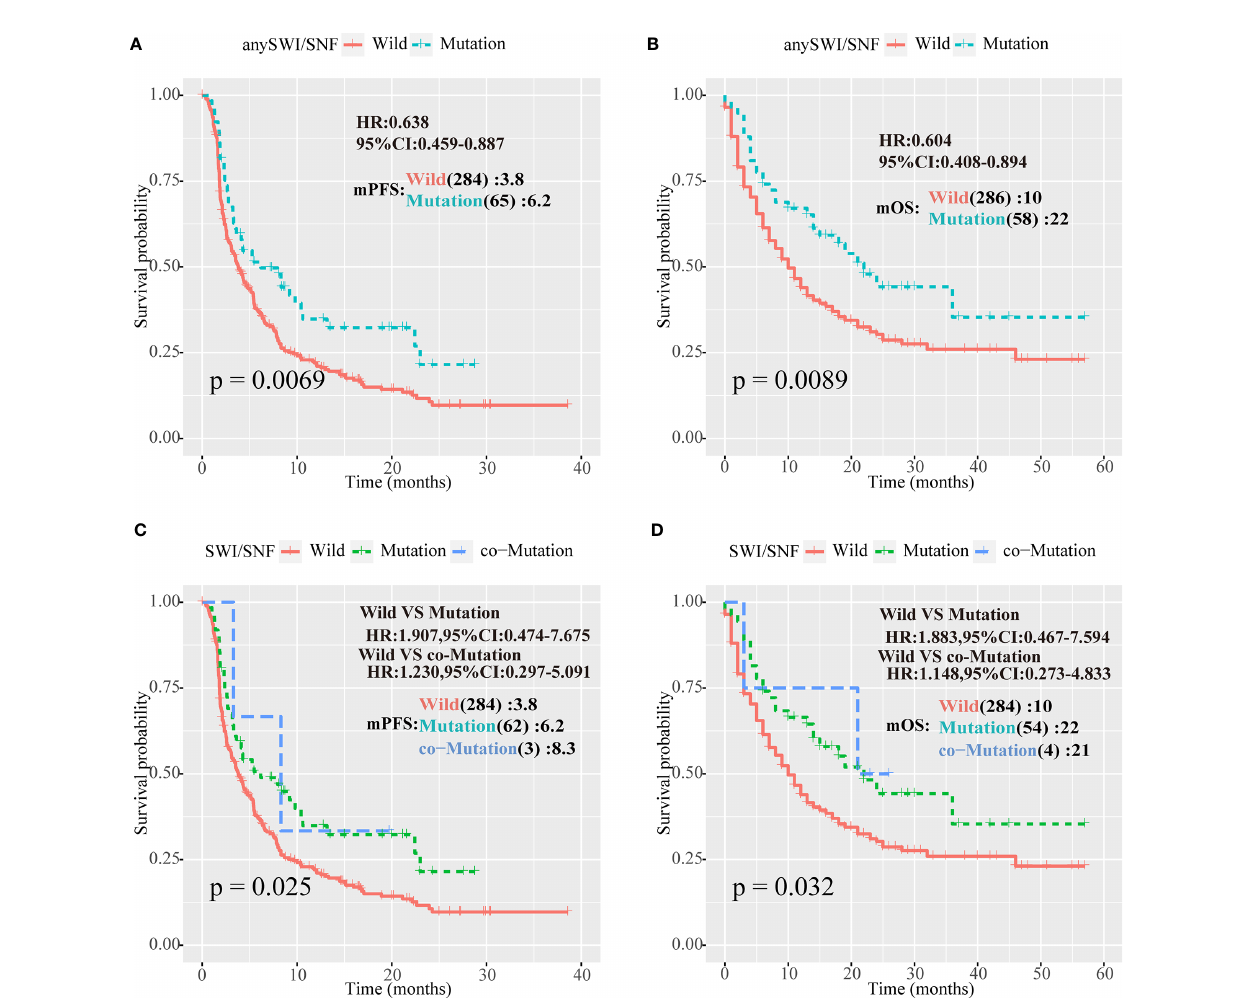
FIGURE 2 | Human switch/sucrose nonfermentable (SWI/SNF) complex mutations were associated with better outcomes for patients with NSCLC treated with PD- 1/PD-L1 inhibitors. (A, B) Survival curves of progression-free survival (PFS) for the Hellmann, Rizvi, and Naiyer (HRN) cohort, and of overall survival (OS) for the Samstein cohort according to ARID1A , ARID1B , and ARID2 mutations in patients with non-small cell lung cancer (NSCLC). Patients with at least one mutation in one of the three genes were part of the human switch/sucrose nonfermentable (SWI/SNF) complex mutation group, and the remaining patients were part of the wild-type (WT) group. (C, D) PFS curve for the Rizvi cohort and OS for the Samstein cohort according to ARID1A , ARID1B , and ARID2 mutations in NSCLC patients. Patients with no mutations in any of the three genes formed the WT group, patients with one mutation were part of the one-mutation group, and patients with two or more mutations formed the co-mutation